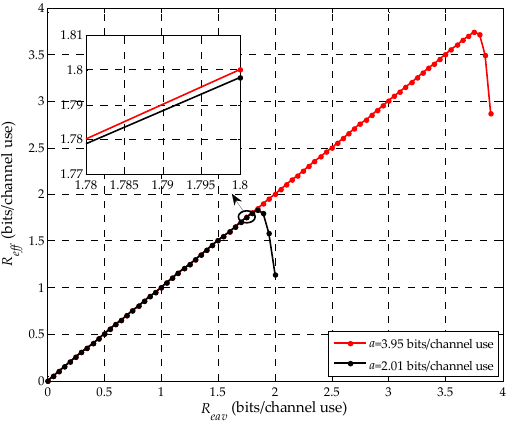
R given in Equation (9). Figure 4. R ef f vs R eav given in Equation R vs eff eav